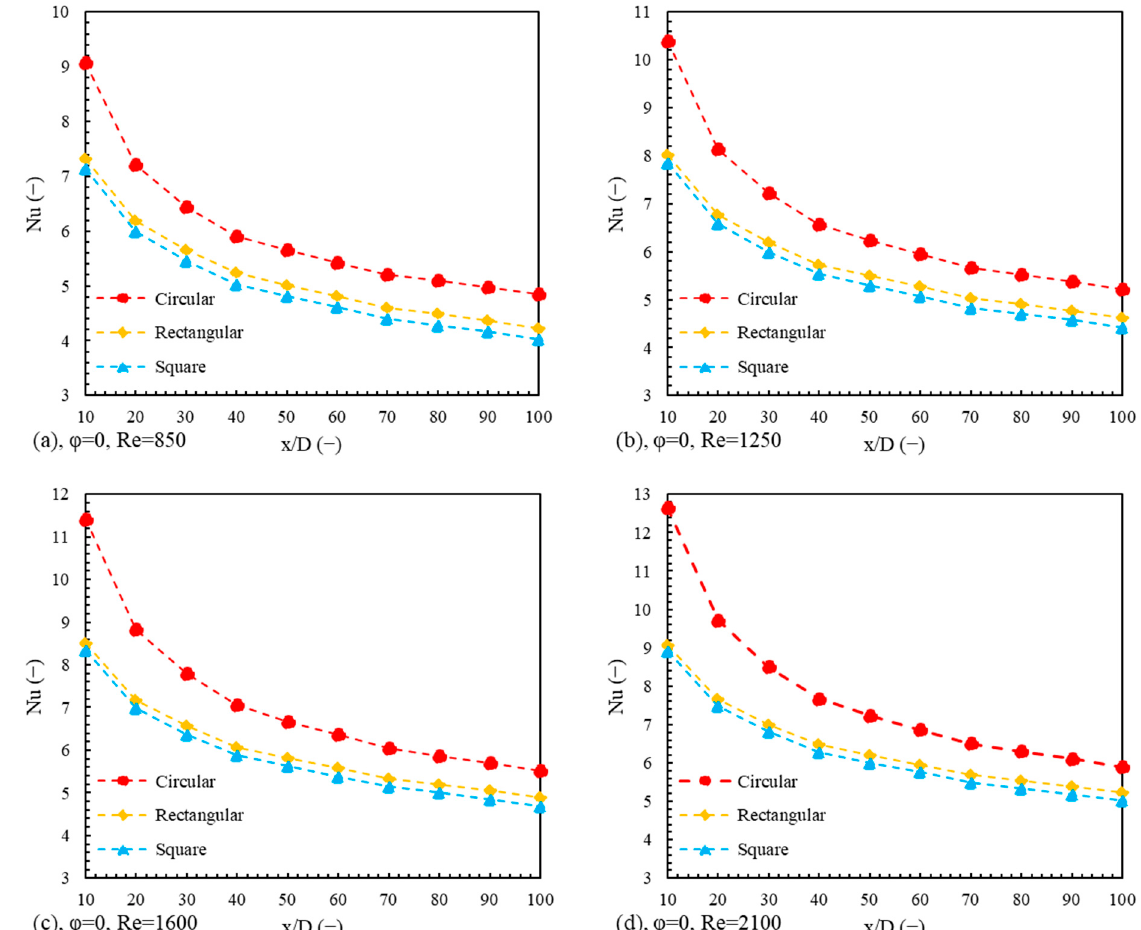
Figure 3. Local Nu of water with different cross-sections in ( a ) Re = 850, ( b ) Re = 1250, ( c ) Re = 1600, and ( d ) Re = 2100.